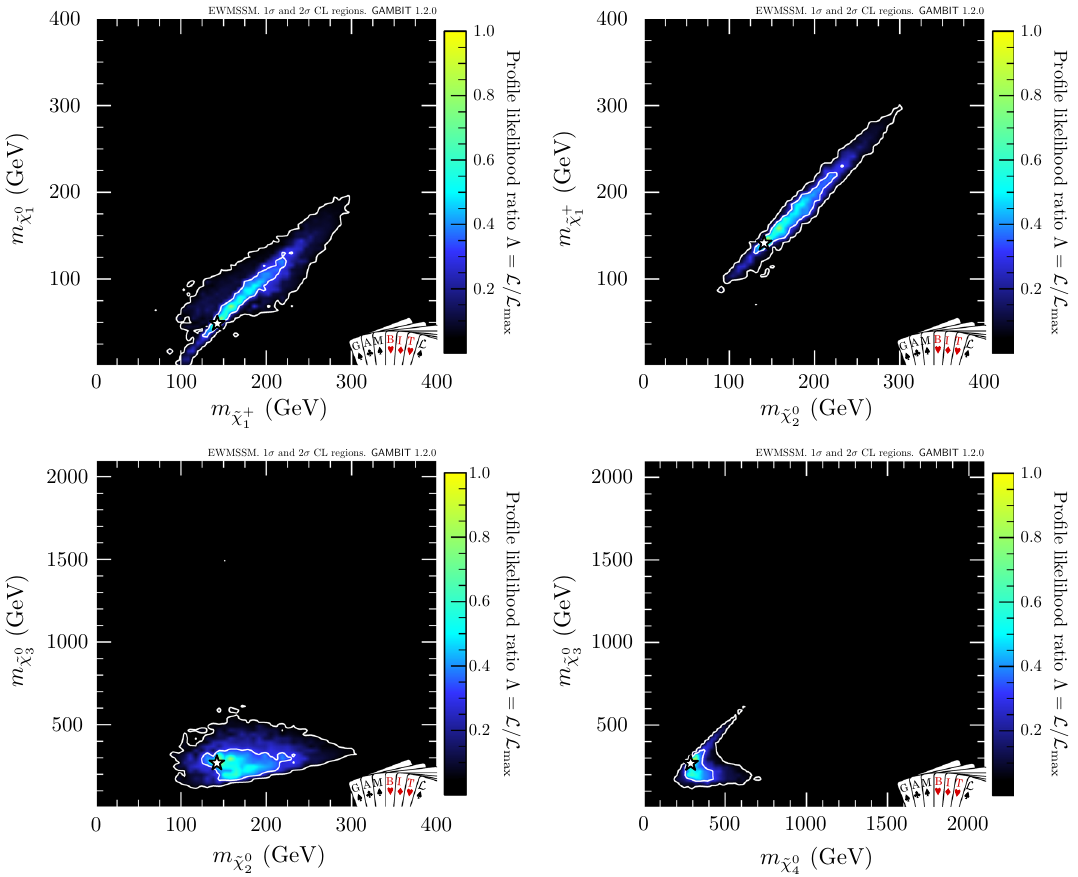
, m ) plane (upper left), the ( m ˜ χ 0 1 1